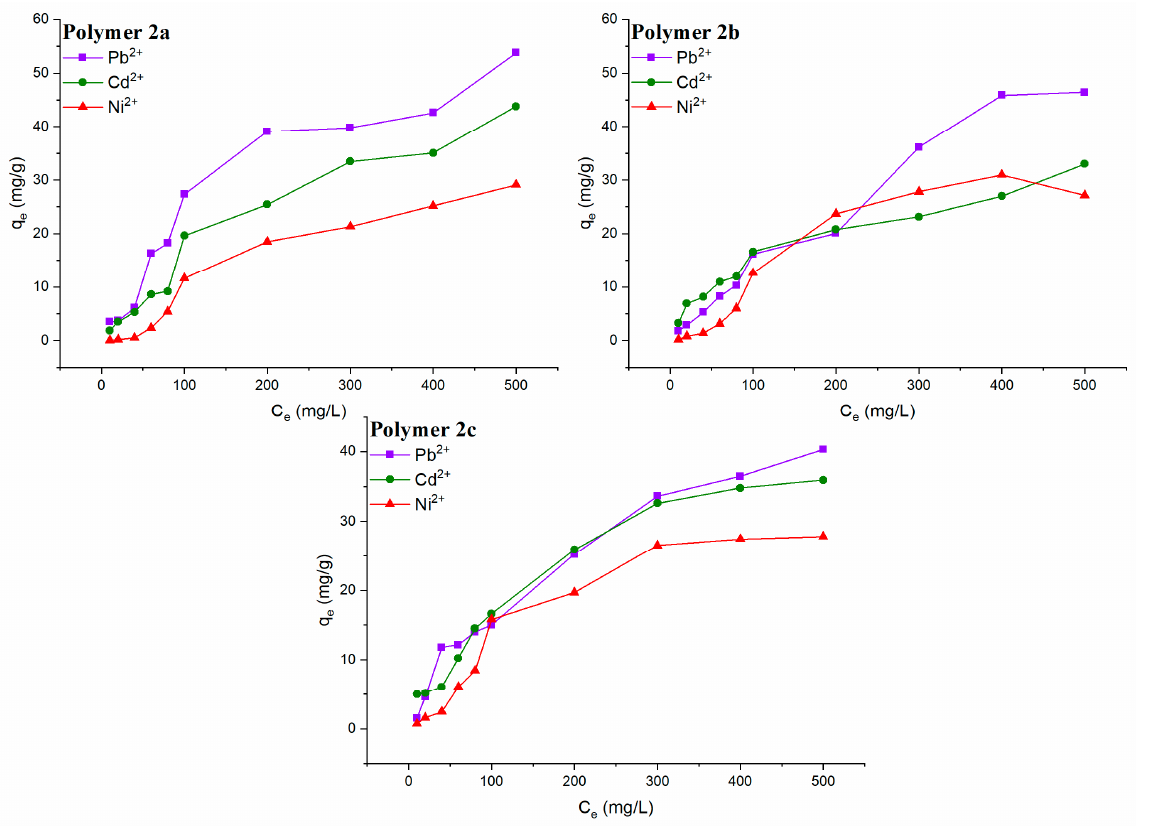
Figure 8. Amount of Pb +2 , Cd 2+ and Ni 2+ adsorbed by the polymers 2a , 2b and 2c as a function of the heavy metal solution concentration ( C e ).